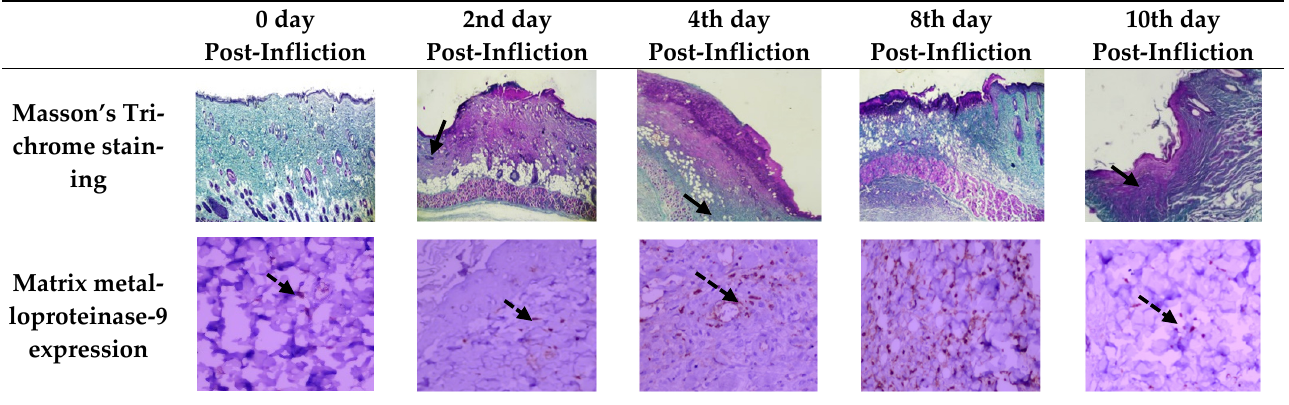
Figure 3. Representative of Masson Trichome staining (magnification, ×40) and metalloproteinase-9 expression (magnification, ×400) of cutaneous wound lesions on 0, 2nd, 4th, 8th, and 10th days post-wounding where wound at 0 day showed. Collagen was represented with black arrows, and matrix metalloproteinase-9 was represented with dashed black arrows.